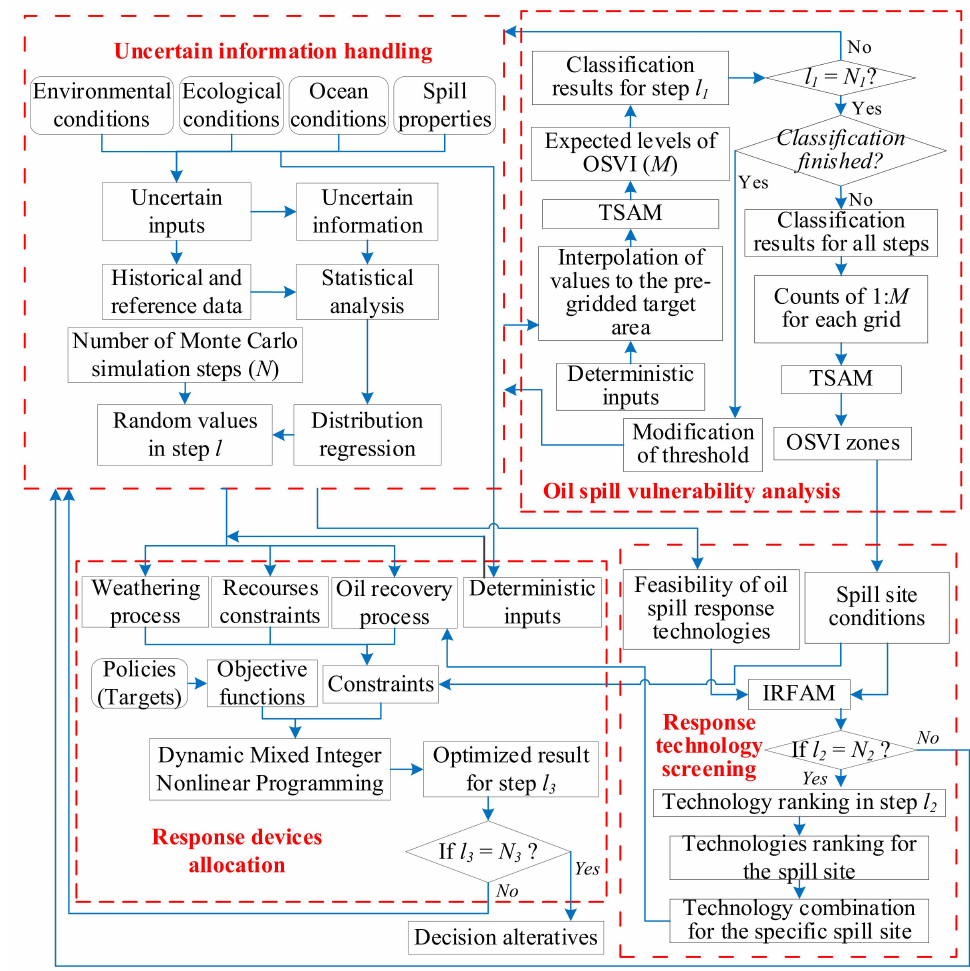
Figure 5. Framework of the